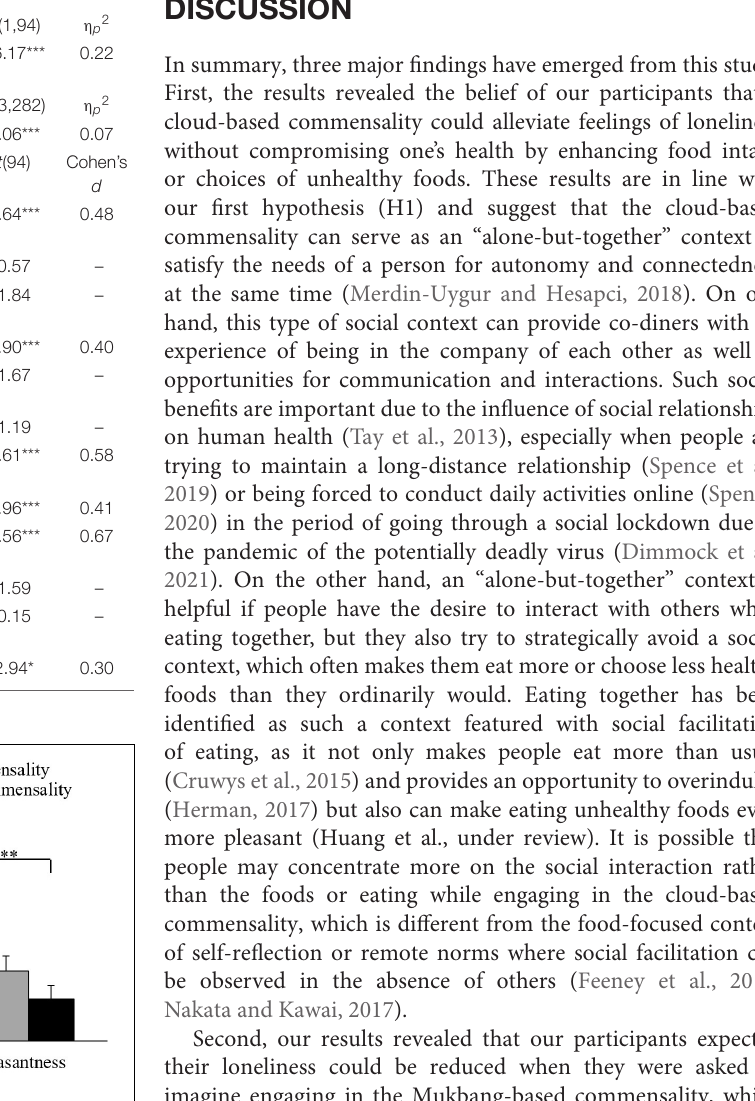
FIGURE 4 | The mean scores of preferences for unhealthy foods (over healthy foods) in different scenarios. The error bars show the standard errors of the means. ∗∗ p < 0.01, and ∗∗∗ p <